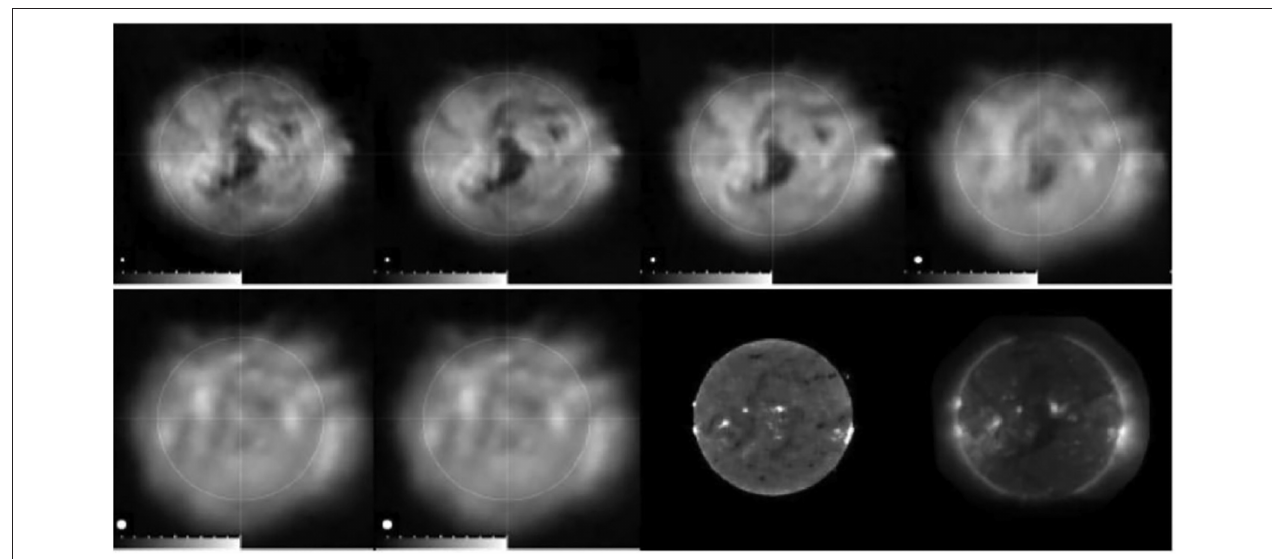
FIGURE 3 | Solar images on 2004 June 27. From left to right and from top to bottom: NRH images obtained at 432, 410, 327, 236, 164, and 150 MHz, NoRH image at 17 GHz, and soft X-rays image obtained from the Solar X-Ray Imager (SXI) on board GOES12 (from Mercier and Chambe, 2009). © AAS. Reproduced with